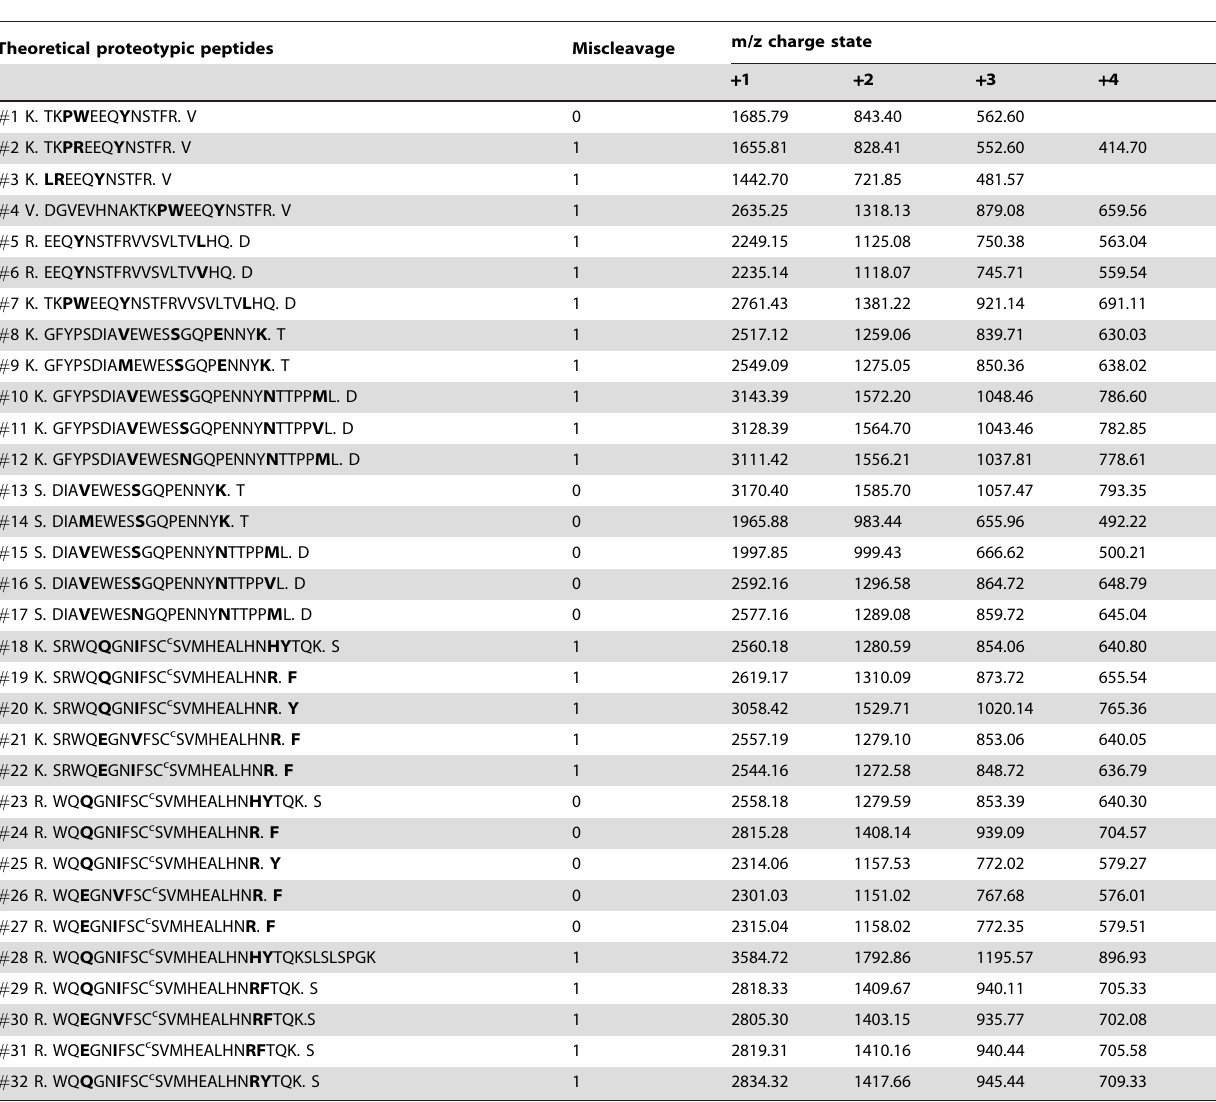
The proteotypic peptides correspond to an enzymatic AspN and trypsin digestion of the constant region of the IG gamma3 chains encoded by the Homo sapiens IGHG3 gene. Masses are determined for detection on the MALDI TOF and ESI Orbitrap mass spectrometers. The methionine (M) could be oxidized ( + 16 Da). m/z : mass-to- charge ratio; + 1, + 2, + 3, + 4 represent the peptide charge state; amino acids in bold are implicated in the discrimination between G3m and IGHG3 alleles (detailed in Table 2); «.» : site of enzymatic cut; C c : carbamidomethylated